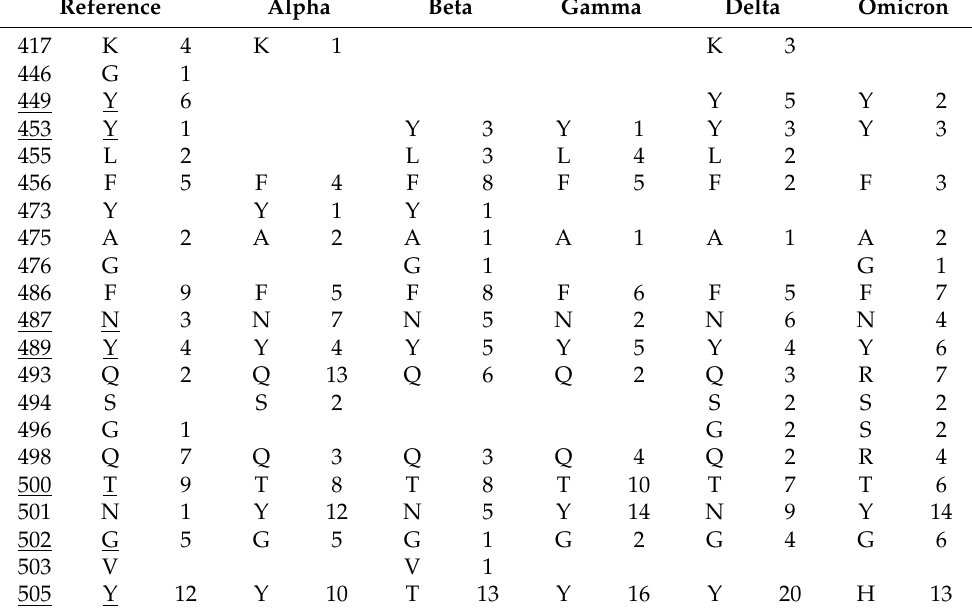
Table 2. Contact residues of the Wuhan original sequence of SARS-CoV-2 and the VOCs with the receptor ACE2. The list of the contact residues for every RBD is listed. The number at the right of each residue is the number of contacts of that specific residue. The underlined position refers to conserved positions from ACE2 binding to S proteins. The shadowed positions are contact residues that have not mutated in VOCs and the red residues are the mutated contact residue.